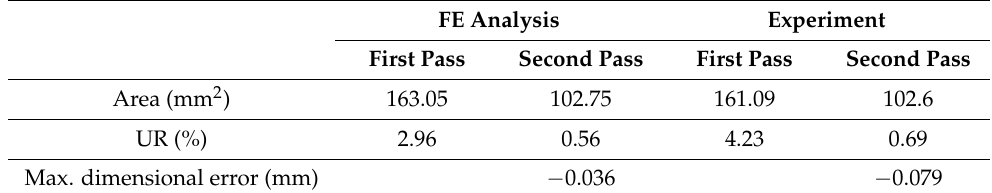
(cid:0) A target = 103.33 mm 2 )